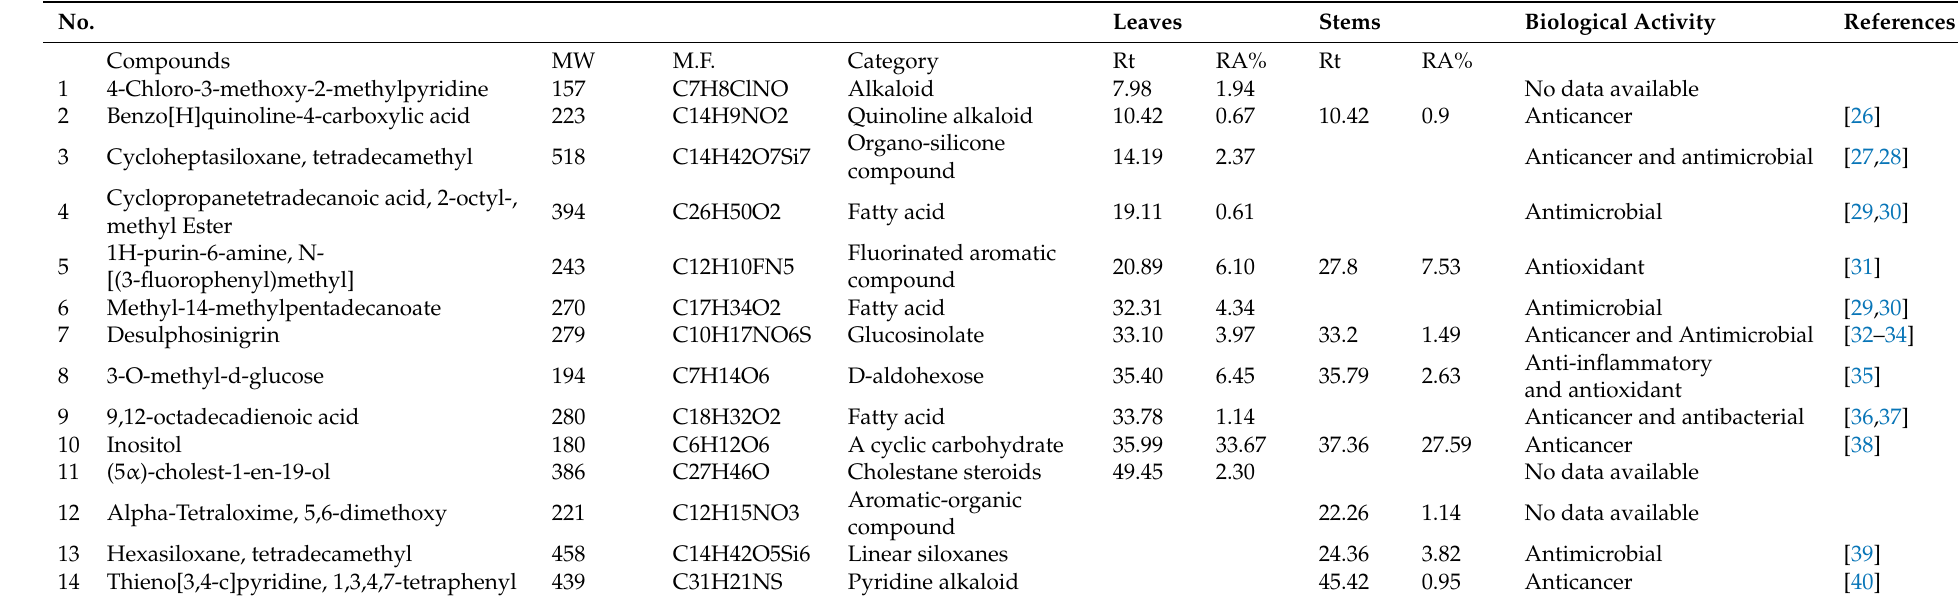
Table 1. Active principal identification of extracts from the leaves and stems of Rhizophora mucronata by